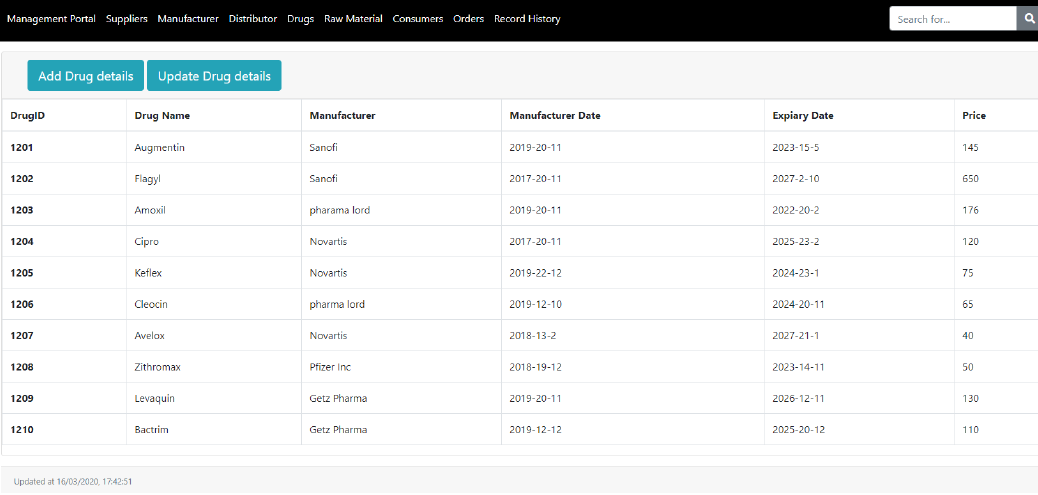
Figure 13. Drug management portal for adding, updating and checking